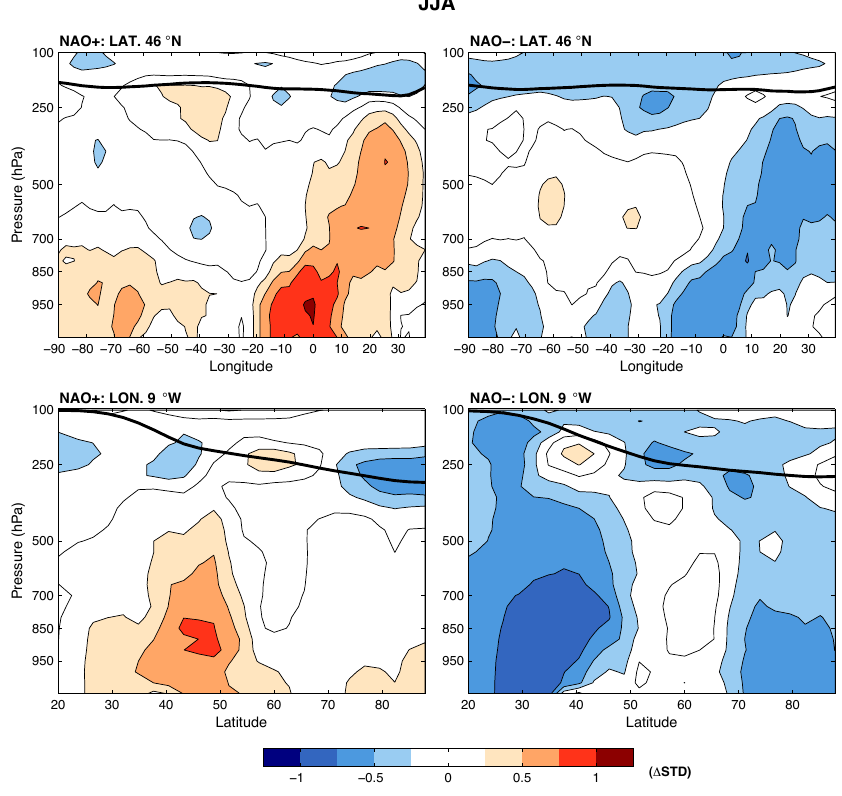
Fig. 10. Transect of normalized CO mixing ratio anomalies for a given latitude (upper panels) and longitude (lower panels) as a function of pressure in summer. CO mixing ratio anomalies are normalized by CO standard deviation. Thick solid line indicates the tropopause height.